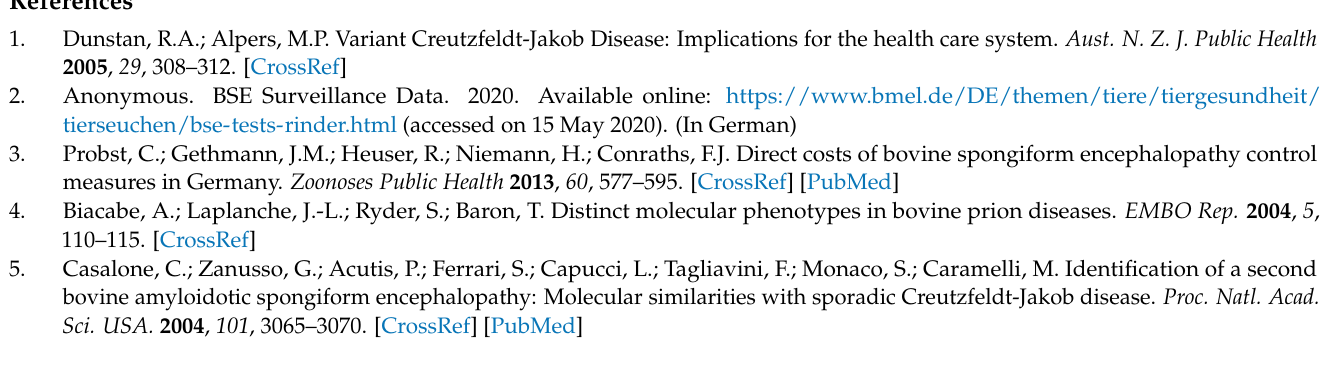
Figure S2: Observed apparent BSE prevalence (per 100,000 heads slaughtered), model-based esti- mated BSE prevalence adjusted for misclassification and estimated number of non-detects for German cattle birth cohorts 1990–2015. 95% confidence limits are